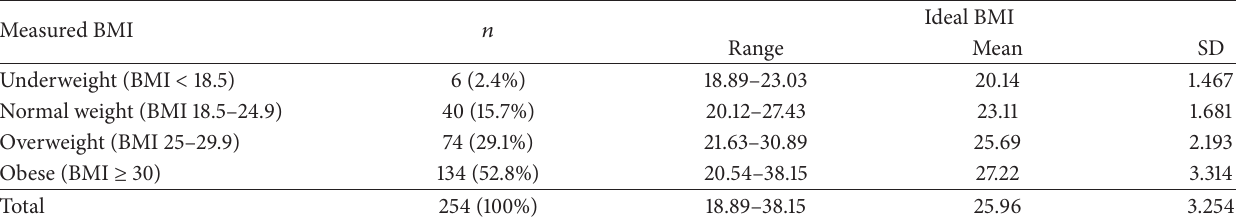
Table 4: Ideal BMI responses compared between the BMI